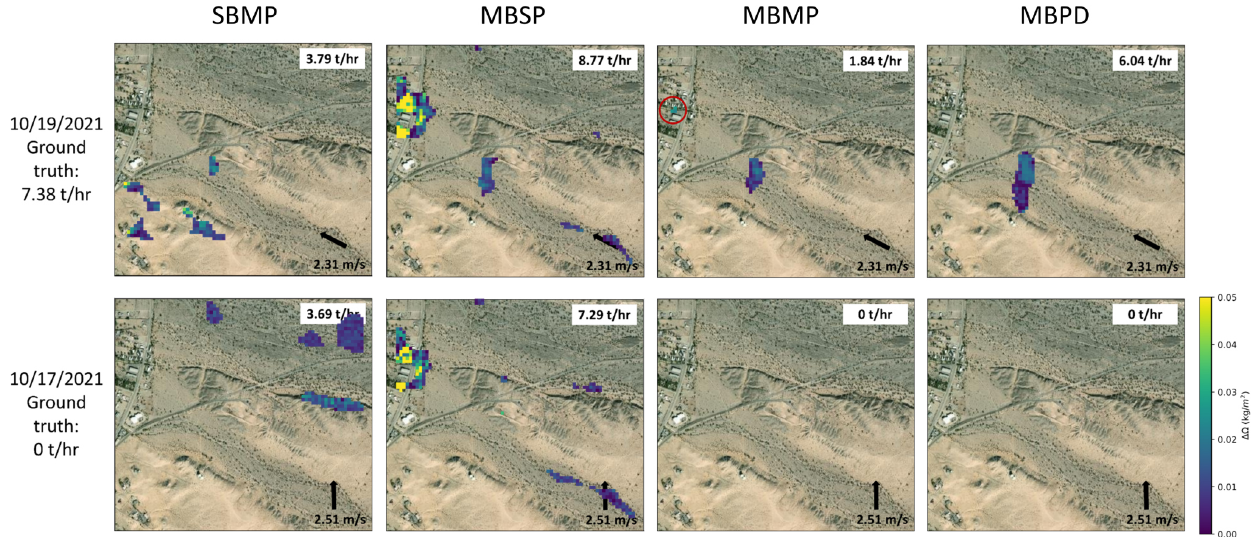
Figure 7. Comparison of four retrieval methods. The performance of multi-band–multi-pass–multi-comparison-date (MBPD) algorithm is compared with multi-band–multi-pass (MBMP) method, multi-band–single-pass (MBSP) method and single-band–multi-pass (SBMP) method from Varon et al. (2021) for two dates, one with a methane plume (19 October 2021) and one with no plume (17 October 2021). The MBPD algorithm performs the best with correct yes/no detection and emission rate estimates closest to the ground-truth volumes. The MBMP retrieval has a small-area false positive detection on 19 October 2021 (red circle), and its emission rate estimate is much lower than the ground truth. MBSP and SBMP methods perform the worst with multiple large-area false positive plumes. The basemap is the ArcGIS Online World Imagery Basemap. The sources for the data used are as follows: Esri, DigitalGlobe, GeoEye, i-cubed, USDA FSA, USGS, AEX, Getmapping, Aerogrid, IGN, IGP, swisstopo, and the GIS User